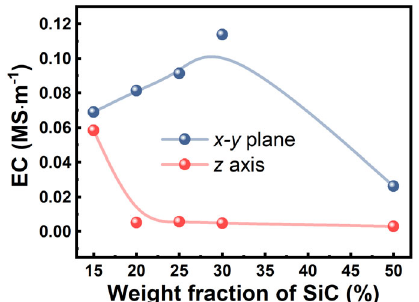
Fig. 5 EC of SiC/GF composites in x – y plane and z axis